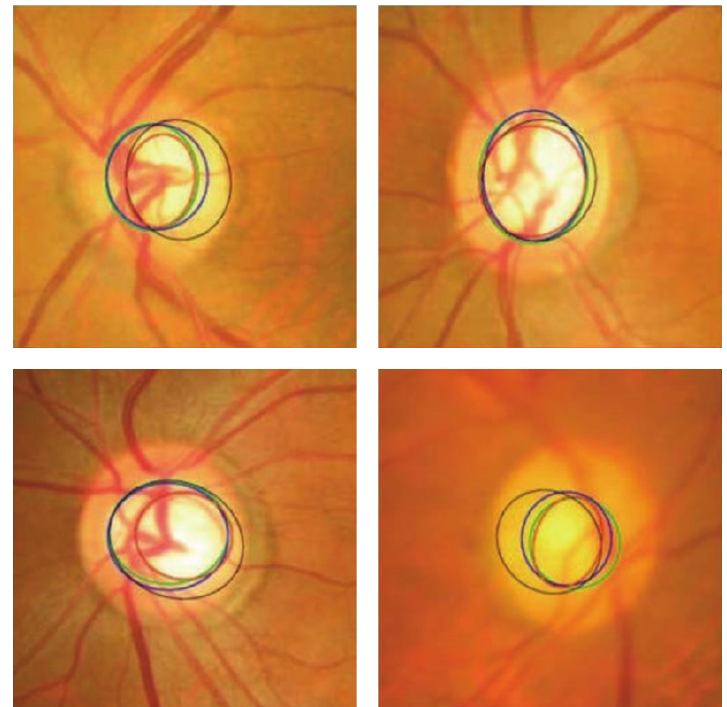
Figure 29: Optic cup segmentation using the proposed method (blue), ASM method without vessel removal (red), and level set method (black) with ground truth (green).